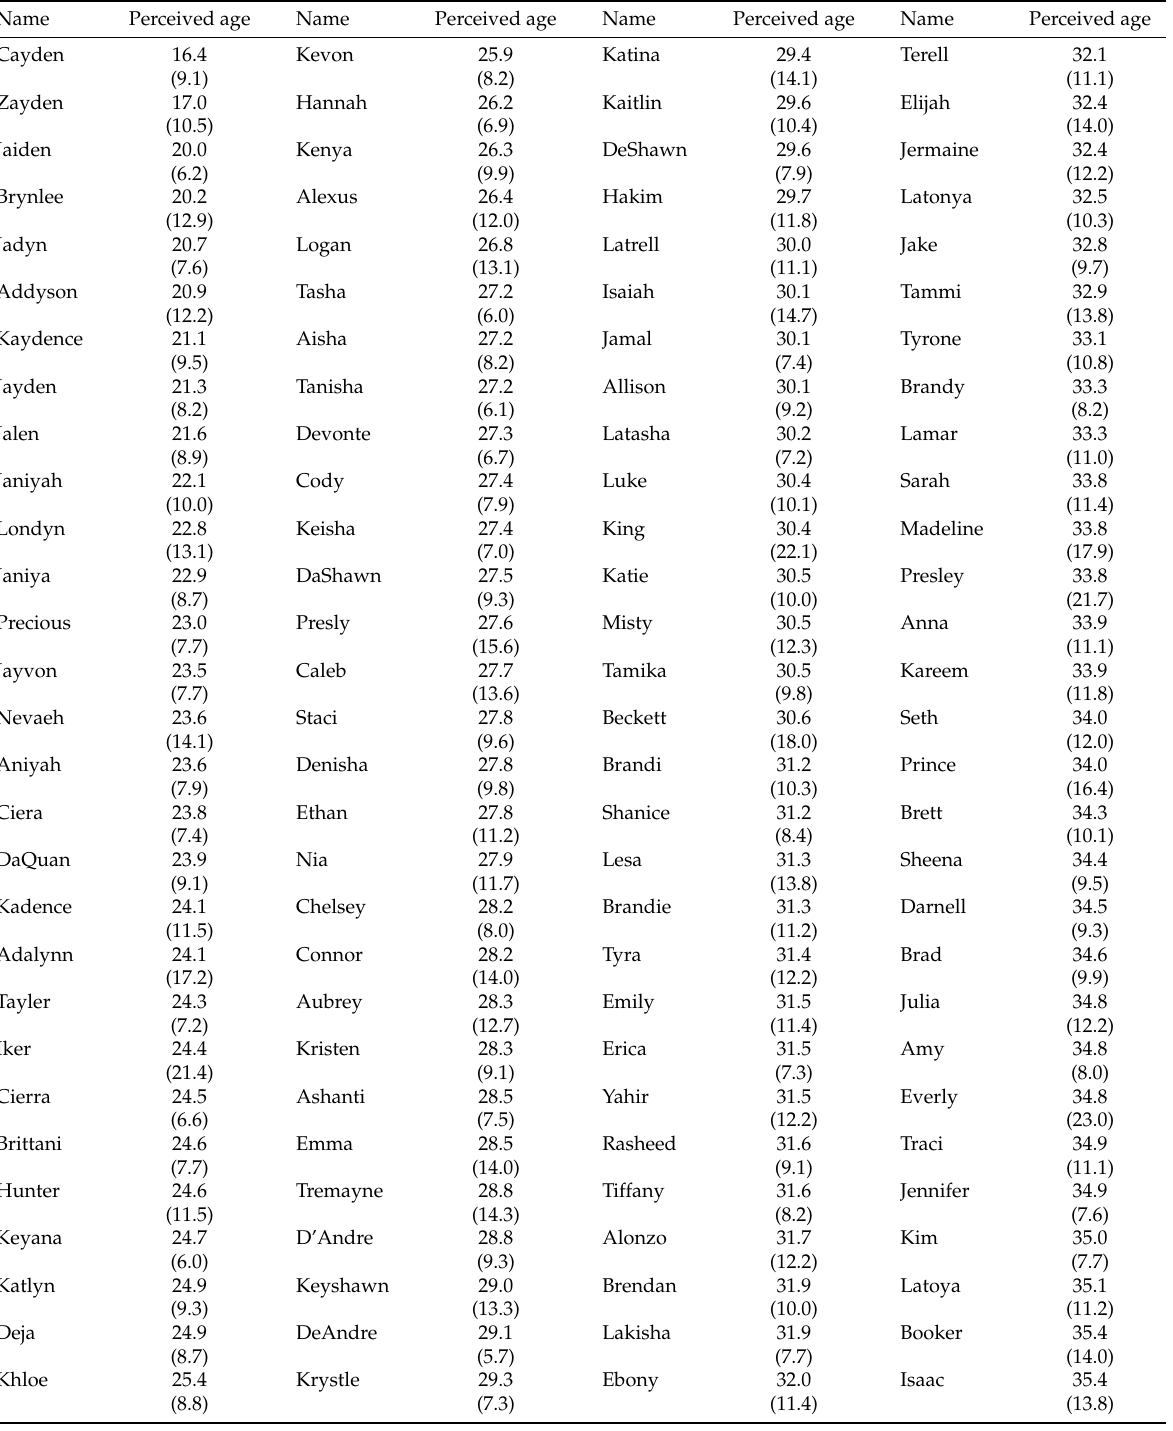
Table 1: Mean perceived chronological age of 228